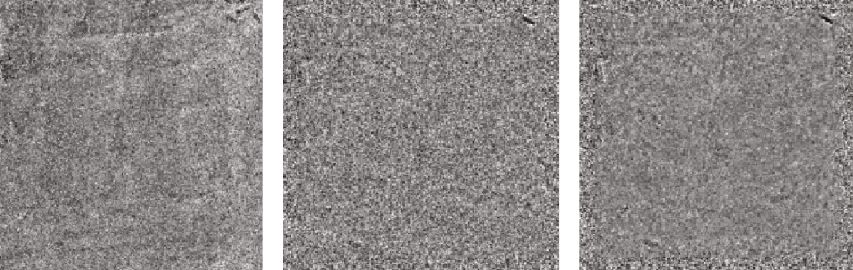
Figure 11: Residual noise of the eighth image of the generated sequence respectively obtained with the ANMCR filter, the MCR filter and the proposed HR filter (see main text).